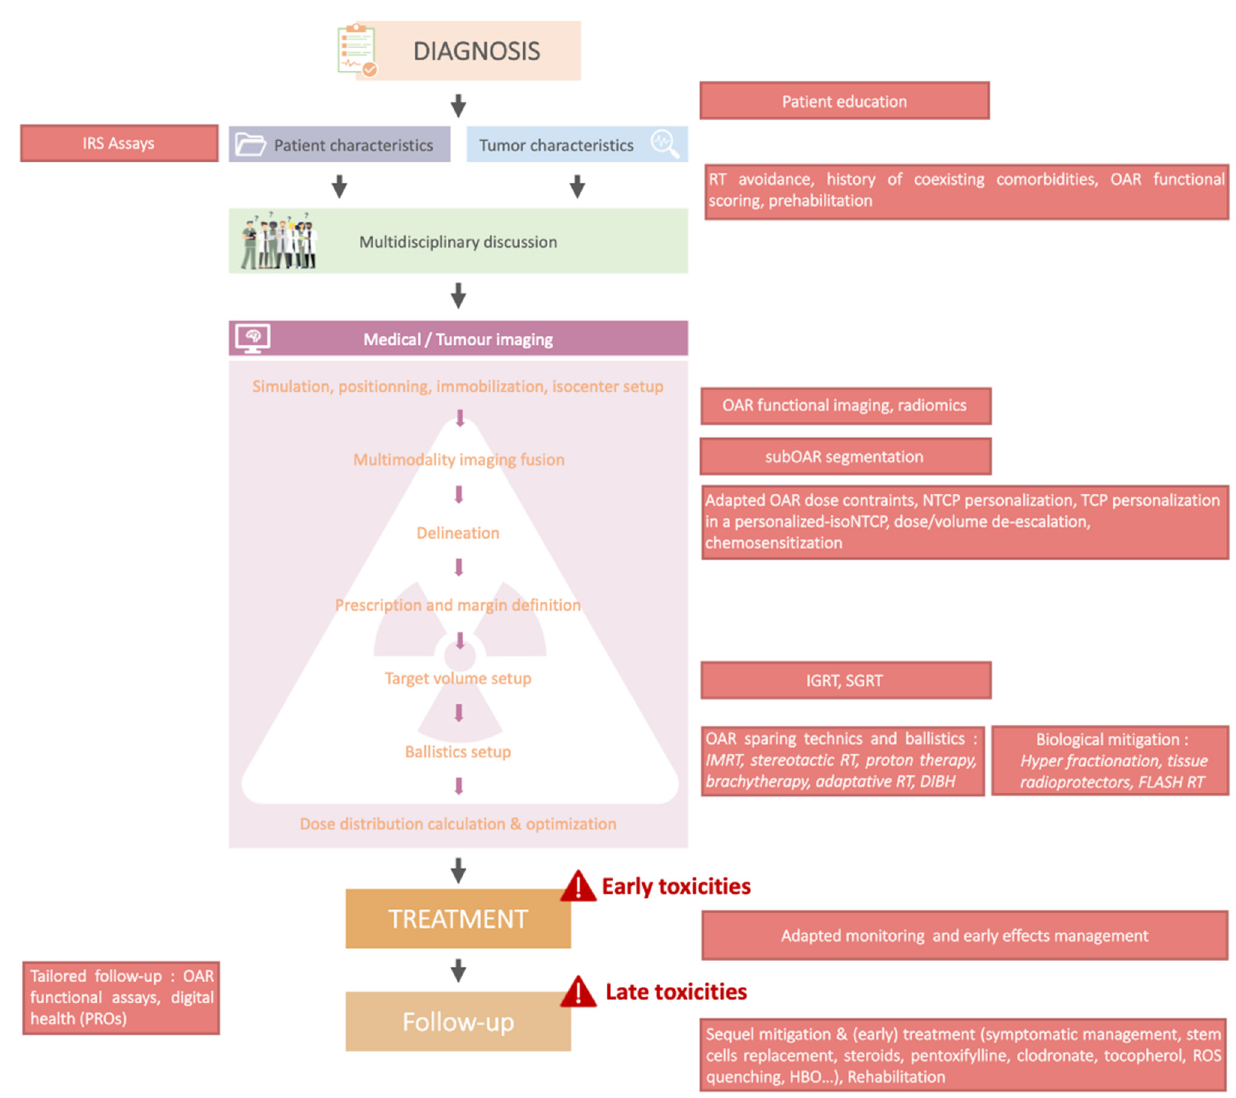
Figure 2. Practical consequences of knowing patients’ iRS of a patient before starting